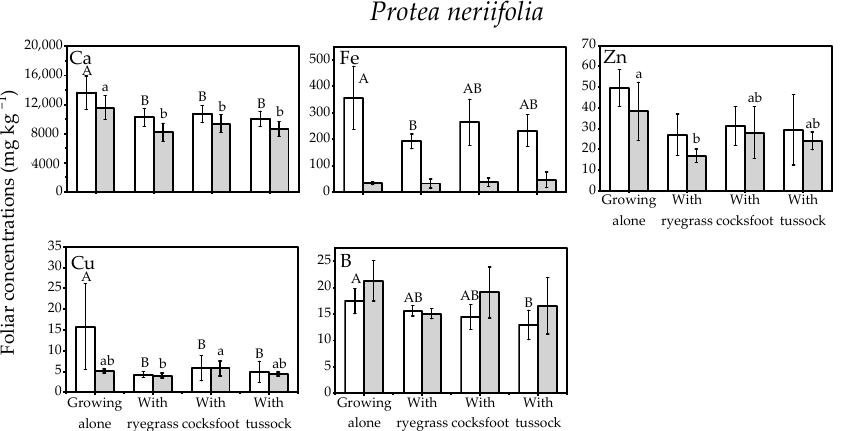
Figure 2. Nutrient concentrations in the foliage of the two Grevillea spp. when they were growing alone or together with Dactylis glomerata (cocksfoot) (open bars, first sampling; shaded bars, final sampling). Different letters each indicate significant differences ( p < 0.05) within each sampling event (upper case letter indicate differences at the first sampling, lower case letters indicate significant differences at final sampling). Elements without significant differences are not shown (full results in Appendix A, Table A1).